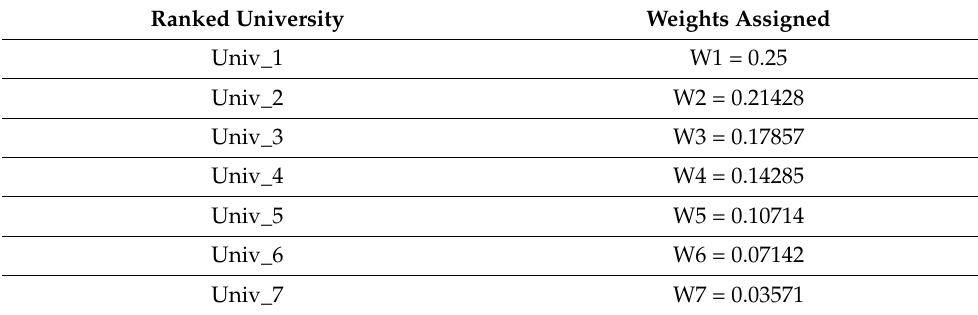
Table 5. Weights assigned to universities by using OWA (most preferred first).